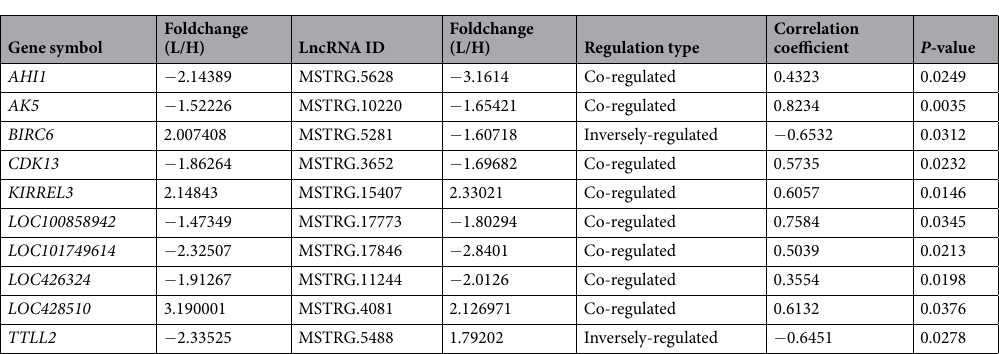
Table 1. Differentially expressed lncRNA-gene pairs between low and high sperm motility groups. Pearson correlation coefficient between expression of lncRNAs and their target genes was